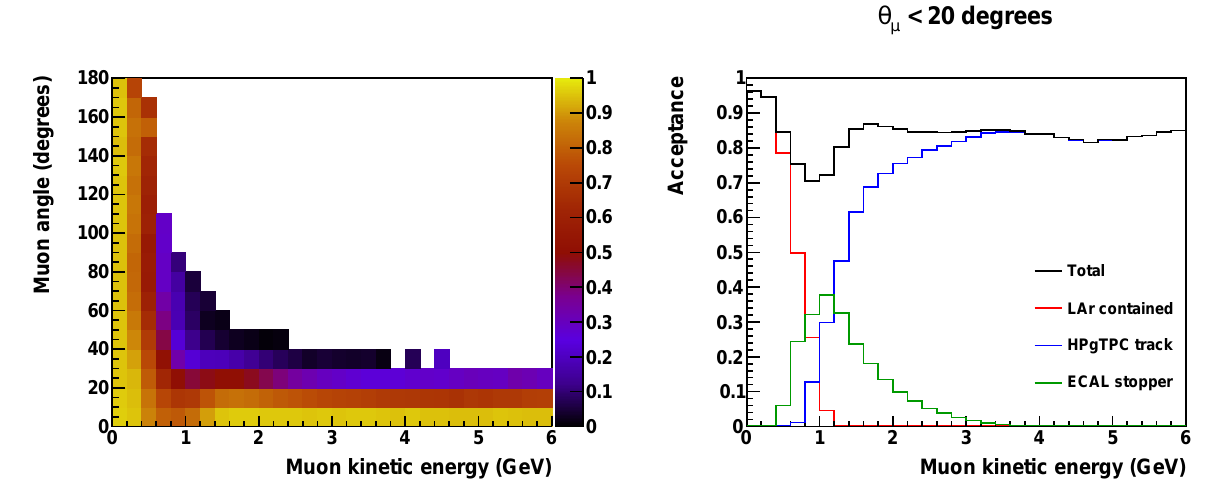
Figure 34. Muon acceptance shown as a function of true muon kinetic energy and angle with respect to the neutrino beam ( left ), and projected onto the muon kinetic energy axis for small angles ( right ). The acceptance includes muons contained in the LArTPC as well as those that stop in the ND-GAr ECAL or match to tracks in the